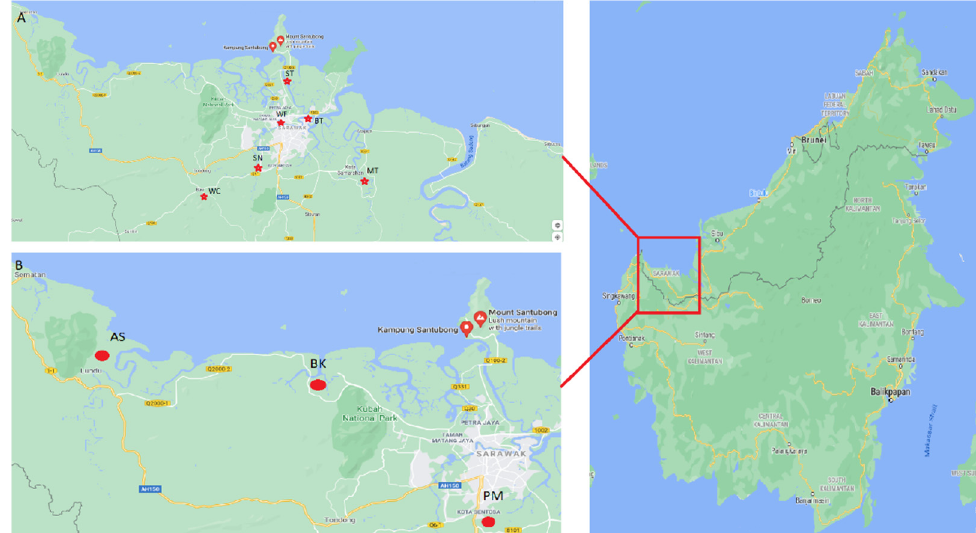
Figure 7. Locations of the study areas in Sarawak, Malaysia, northwestern Borneo (shown in the red box). ( A ) Locations of six sampling stations of rivers and ( B ) locations of three aquaculture farms.